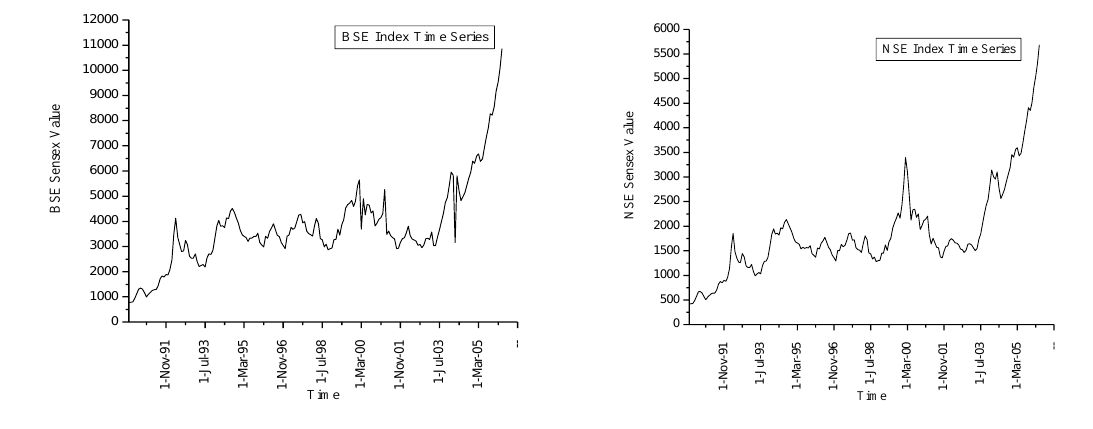
Fig. 3. Financial time series of BSE index Fig. 4. Financial time series of NSE